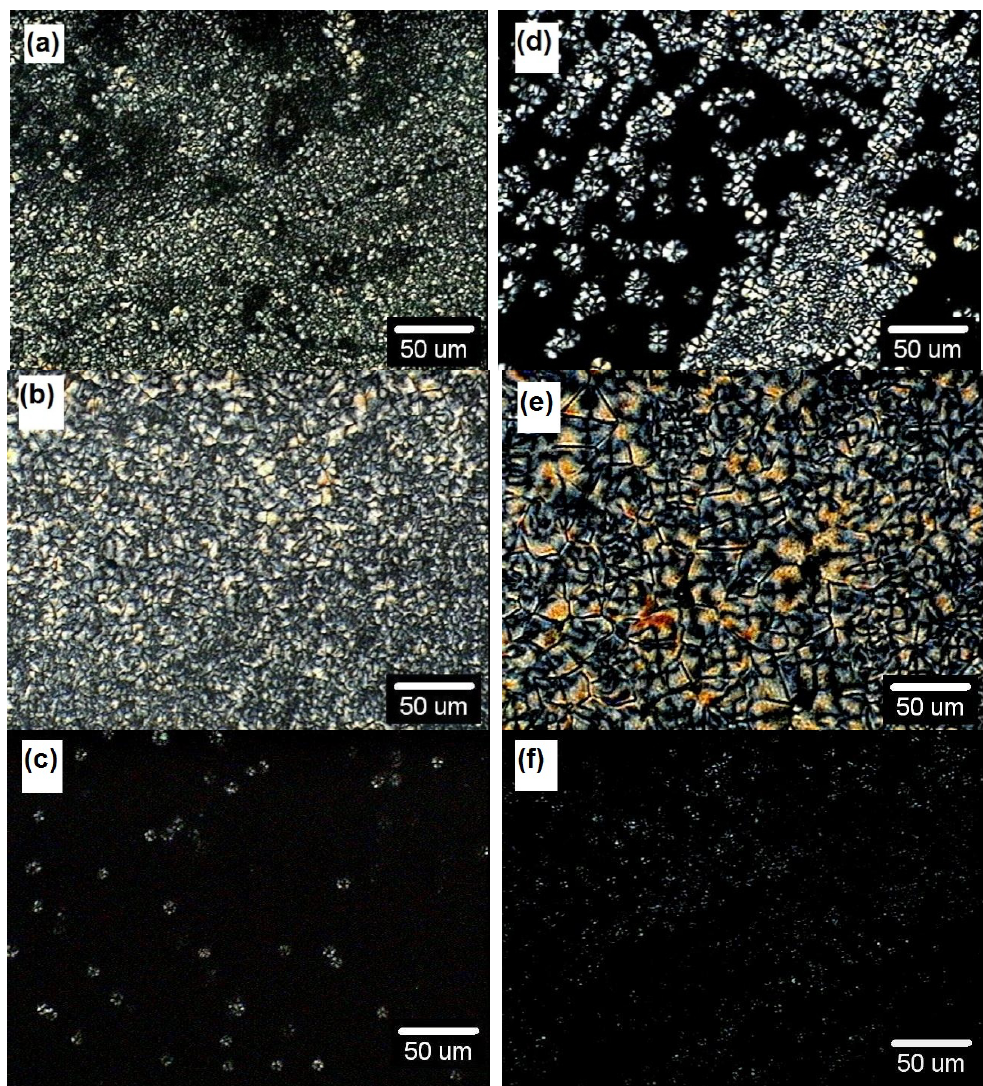
Figure 2. Polarizing optical microscopy (POM) micrographs of isothermally crystallized (5 min) of PET samples at different temperatures. PET-LMw: ( a ) 140 °C; ( b ) 180 °C; and ( c ) 230 °C. PET-HMw: ( d ) 140 °C; ( e ) 180 °C; and ( f ) 230